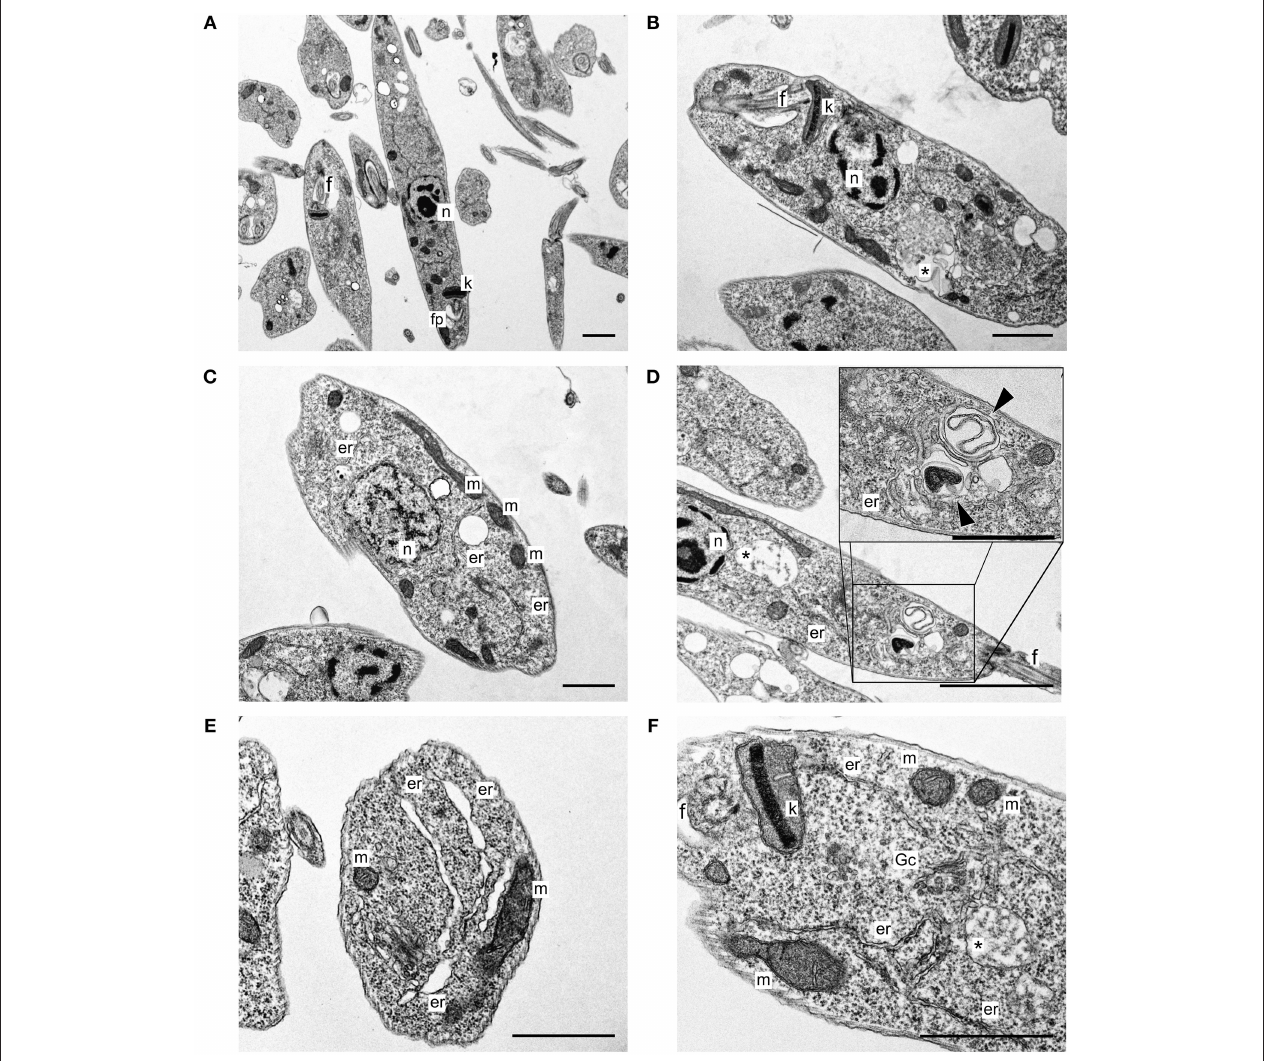
FIGURE 2 | L. infantum promastigotes observed on TEM. (A) Non-treated parasites; (B–F) parasites after 72h of treatment using 4.1 µ g/mL of free sugiol. n , nucleus; k, kinetoplast; f, flagellum; fp, flagellar pocket; *autophagic vacuole; m, mitochondria; er, endoplasmic reticulum; Gc, Golgi complex; (head arrow) myelin-like figures (scale bar = 1 µ